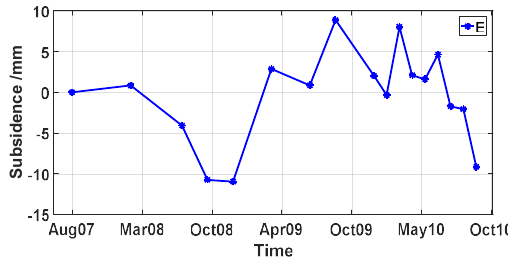
Figure 10. Surface subsidence time series with respect to PS point labeled as E in Figure 4